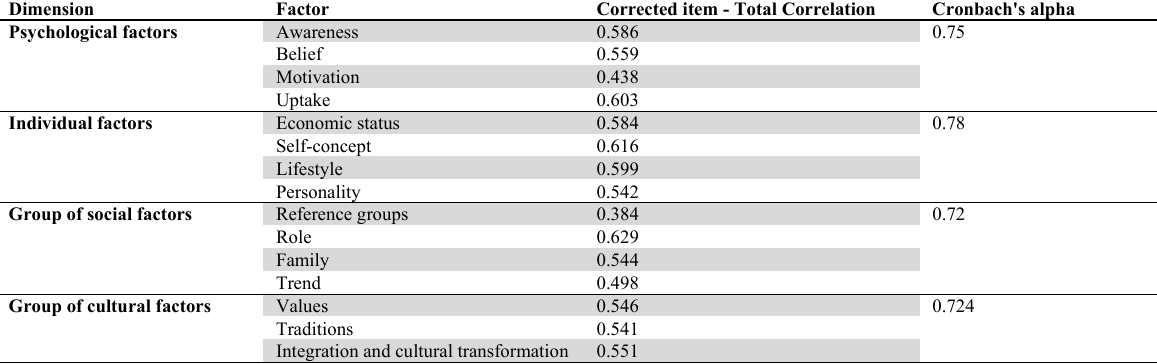
Internal consistency and Item - Total Correlation Coefficients Dimension